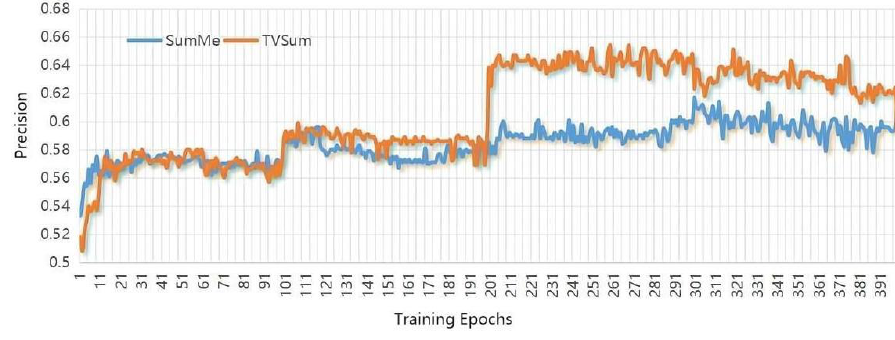
Figure 6. Plots show the influence of training epochs on the value of Precision.